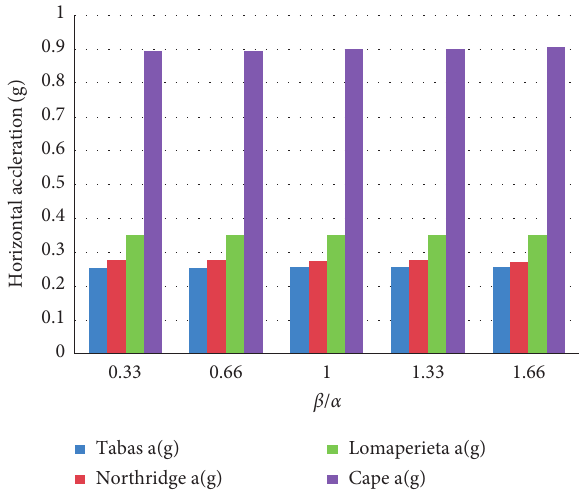
Figure 11: Maximum horizontal acceleration of tunnel lining at load combination 6 to 10.